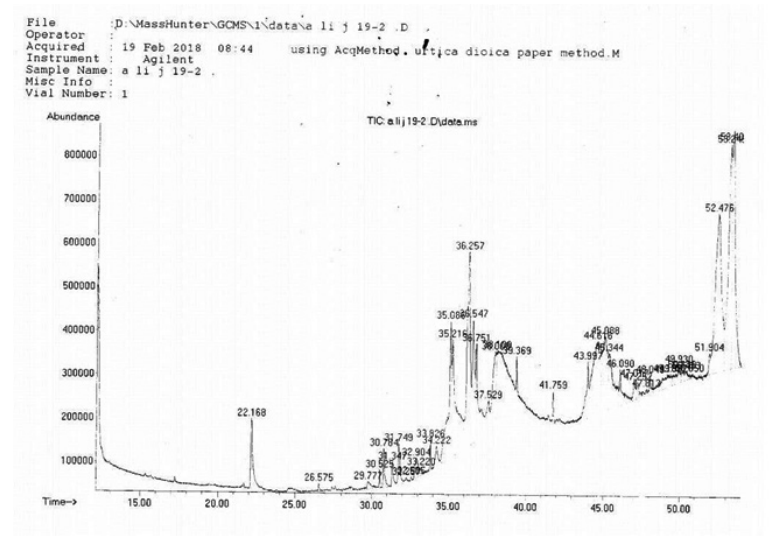
Fig. 5. Determination of chemical compounds in the crude extract of Spirogyra